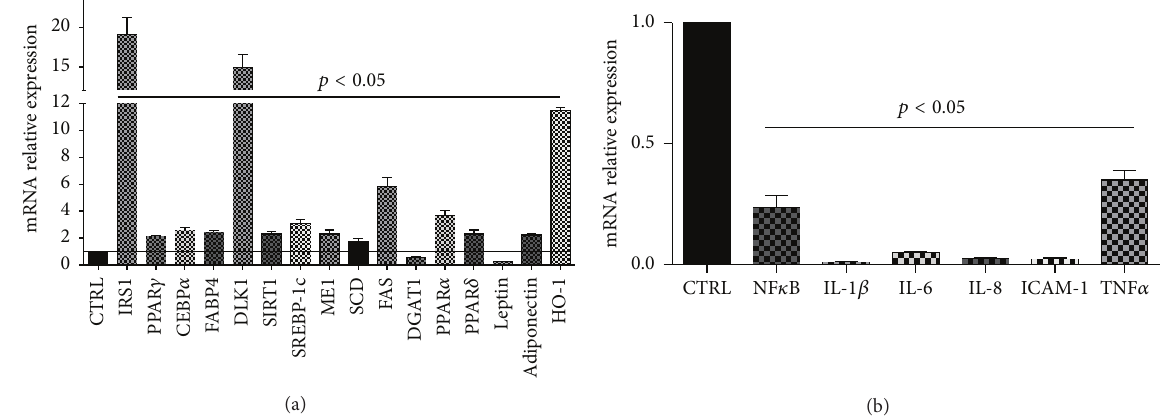
Figure 6: Effect of Cape on cytokines and adipogenic markers. Gene levels are expressed as fold of increase compared to the respective control. Cape was added once after 18 days of differentiation at the concentration of 10 𝜇 M. Values represent the means ± SD of 4 experiments performed in triplicate. ∗ 𝑝 < 0.05 , significant result versus differentiated